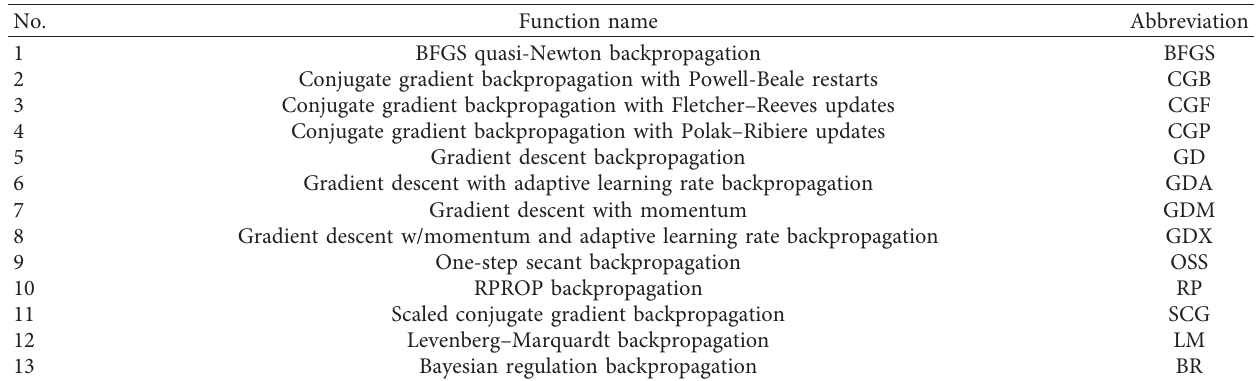
Figure 5: Calculation process for the method used in this Table 2: Summary of training functions.